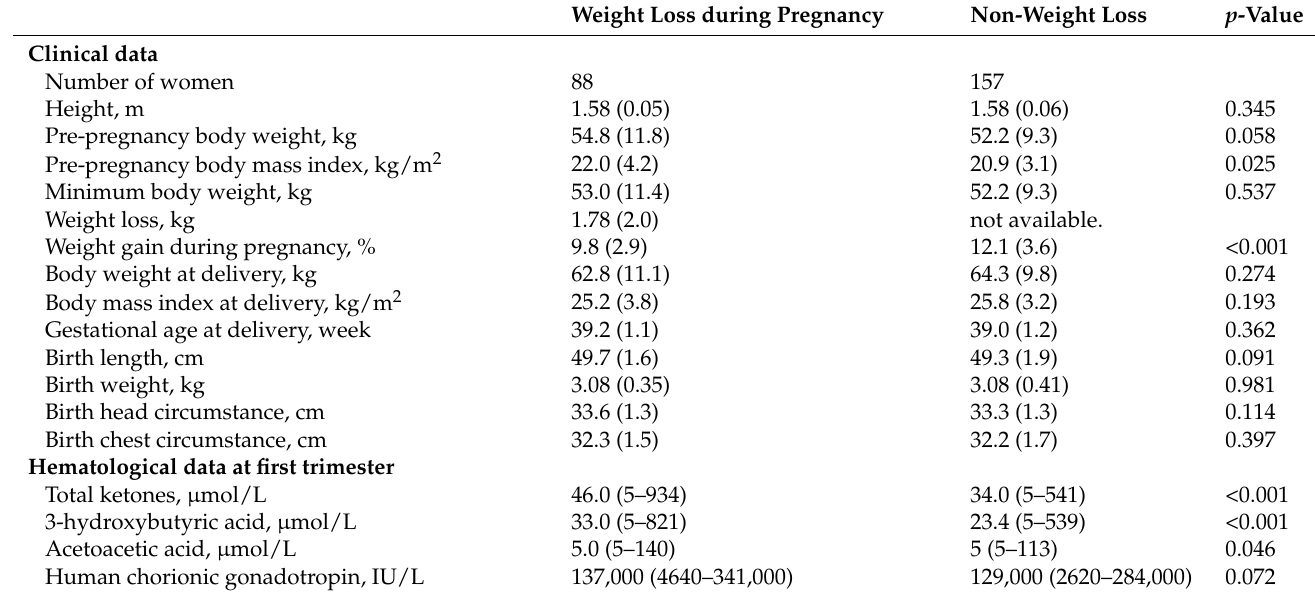
Table 4. Characteristics of the weight-loss and non-weight-loss groups during